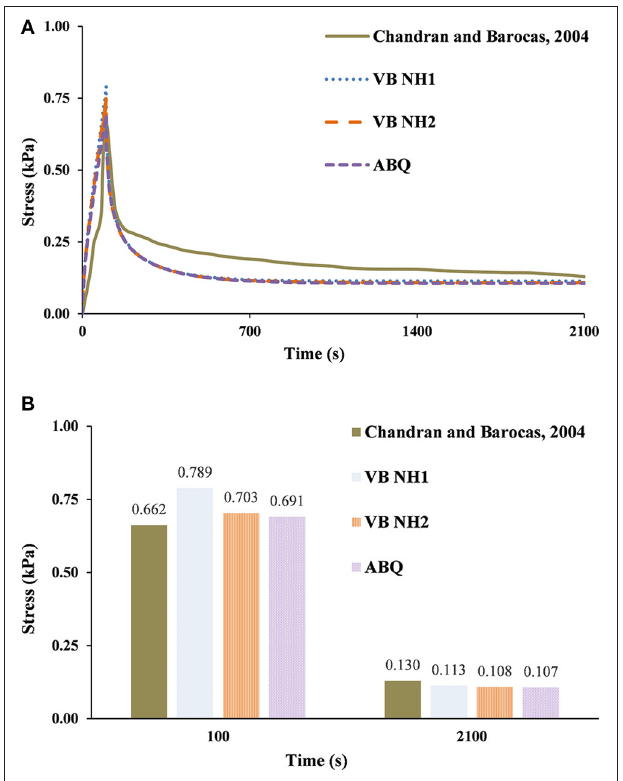
FIGURE 4 | 0.20% collagen hydrogel during 300s stress relaxation test. The experimental data of Busby et al. (2013) is here compared with numerical calculations using V-Biomech, and Abaqus: (A) Stress relaxation over time; (B) Peak and end effective stress